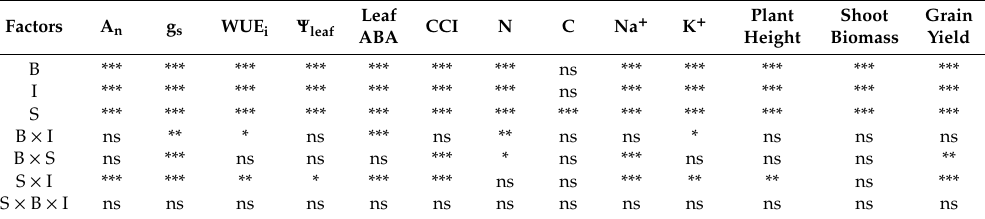
Table 3. Output of three-way ANOVA for leaf photosynthetic rate (A. n ), stomatal conductance (g s ), intrinsic water use e ffi ciency (WUE i ), leaf water potential ( Ψ leaf ), leaf abscisic acid (ABA), chlorophyll content index (CCI), leaf nitrogen content (N), leaf carbon content (C), leaf Na + concentration, leaf K